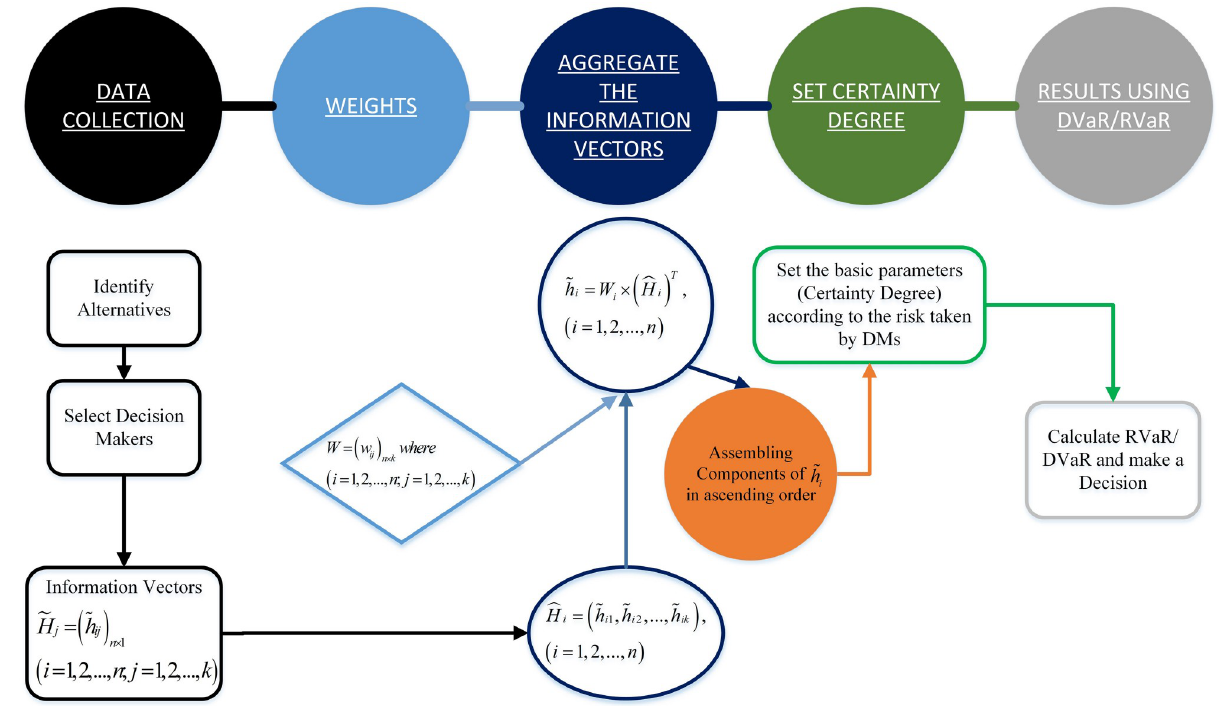
Fig 4. Proposed decision making framework under PIVHF